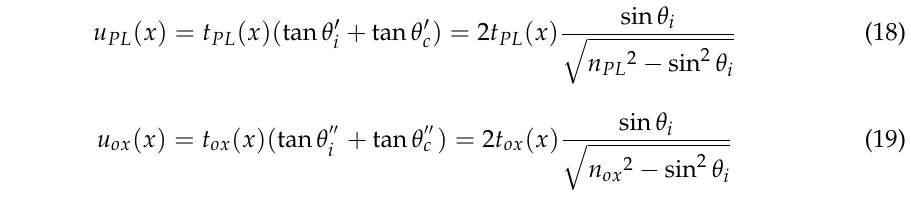
Figure 12. ( a ) Scanning white light interferometer model for measuring the PI thickness. ( b ) Exper- imental results showing the formation of interference fringes at the air–PI and oxide–Si substrate interfaces. The intensity corresponding to the PI–oxide interface was too weak to be